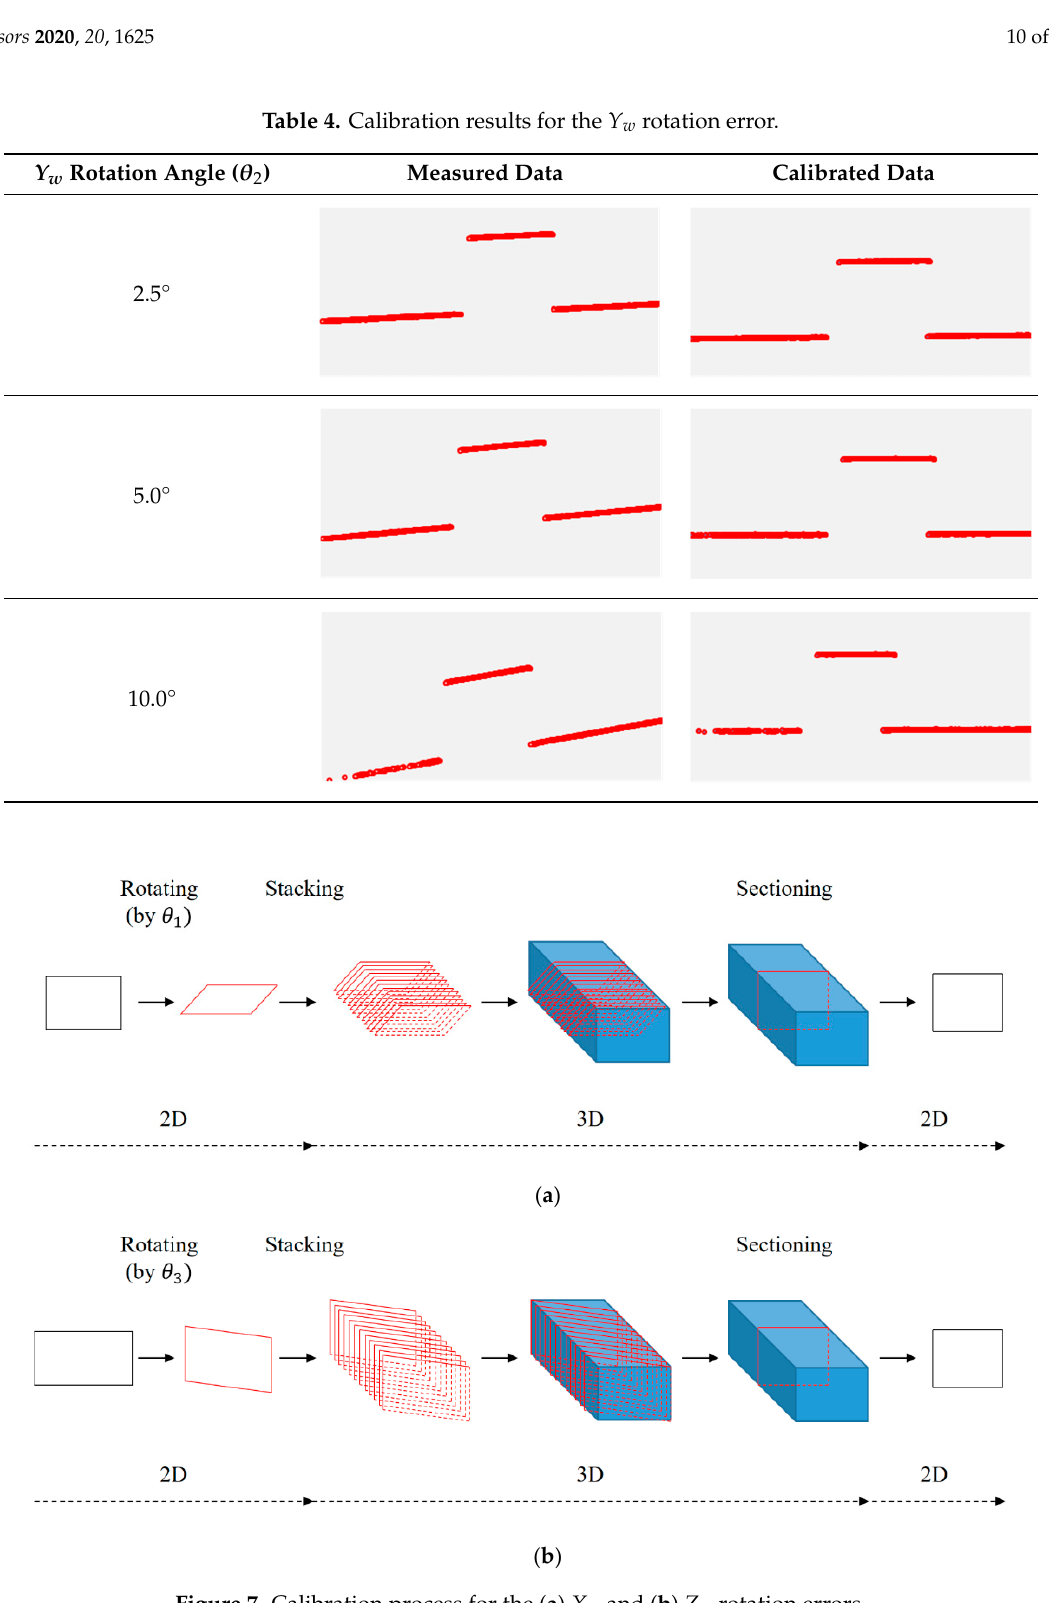
w and ( b ) Z w rotation